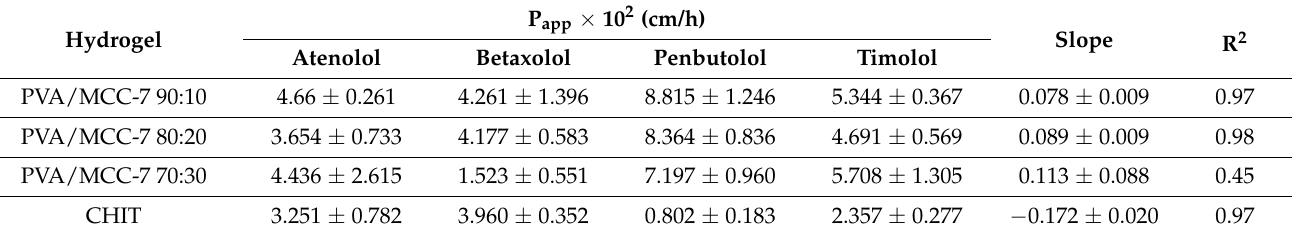
Table 9. Permeation parameters of beta blockers through the different hydrogels (mean ± SE; n = 3).